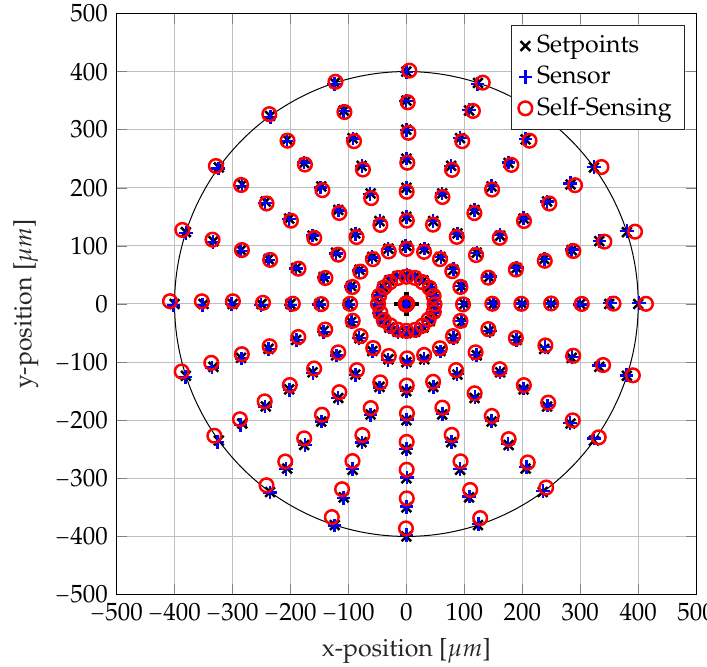
Figure 18. Linearity analysis with external position sensors for different setpoints of the rotor position ( f PWM = 20 kHz, 6-Active